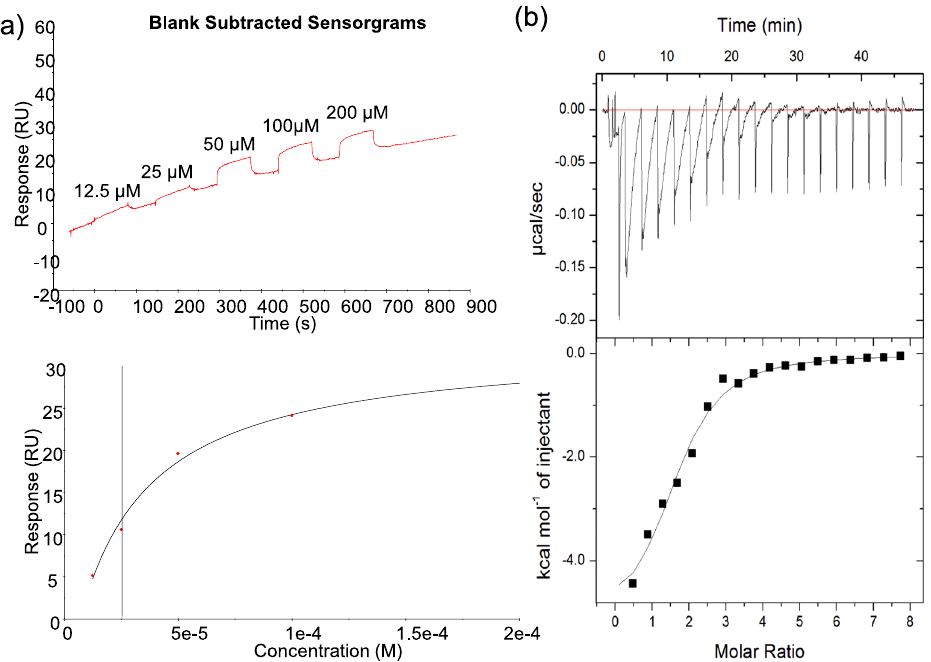
Figure 2. Binding of IMB-YH-8 to PknB as measured by surface plasmon resonance ( a ) and isothermal titration calorimetry ( b) . ( a ) Upper panel: Blank subtracted sensorgram for the binding of IMB-YH-8 (range from 12.5 to 200 μ M). Lower panel: The affinity for IMB-YH-8 binding ( K D = 25.3 μ M) was calculated from the association equilibrium data. ( b ) Thermograms (upper panel) and binding isotherms with theoretical fits (lower panel) obtained for the binding of IMB-YH-8 to